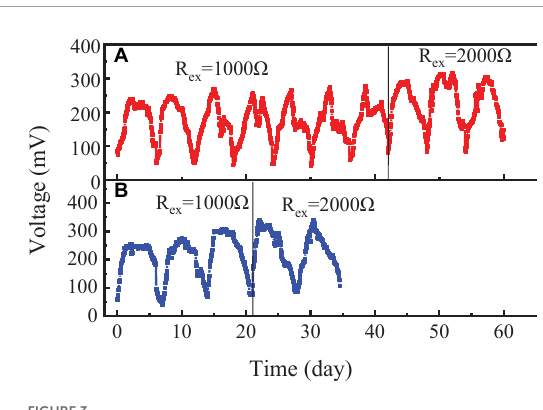
FIGURE3 Voltages of the revolving algae-bacteria biofilm cathode in a photosynthetic membrane-free microbial fuel cell (RAB-MFC) system during the semi-continuous operation with the influent organic strength at chemical oxygen demand (COD) 1,200 mg/L (A) and COD 2,400 mg/L (B) ,